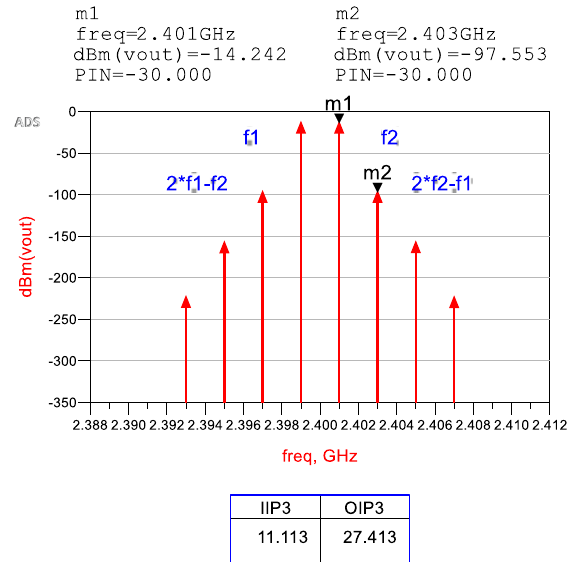
Fig. 21. Two-tone simulation results {f 1 : 2.399 GHz, f 2 :